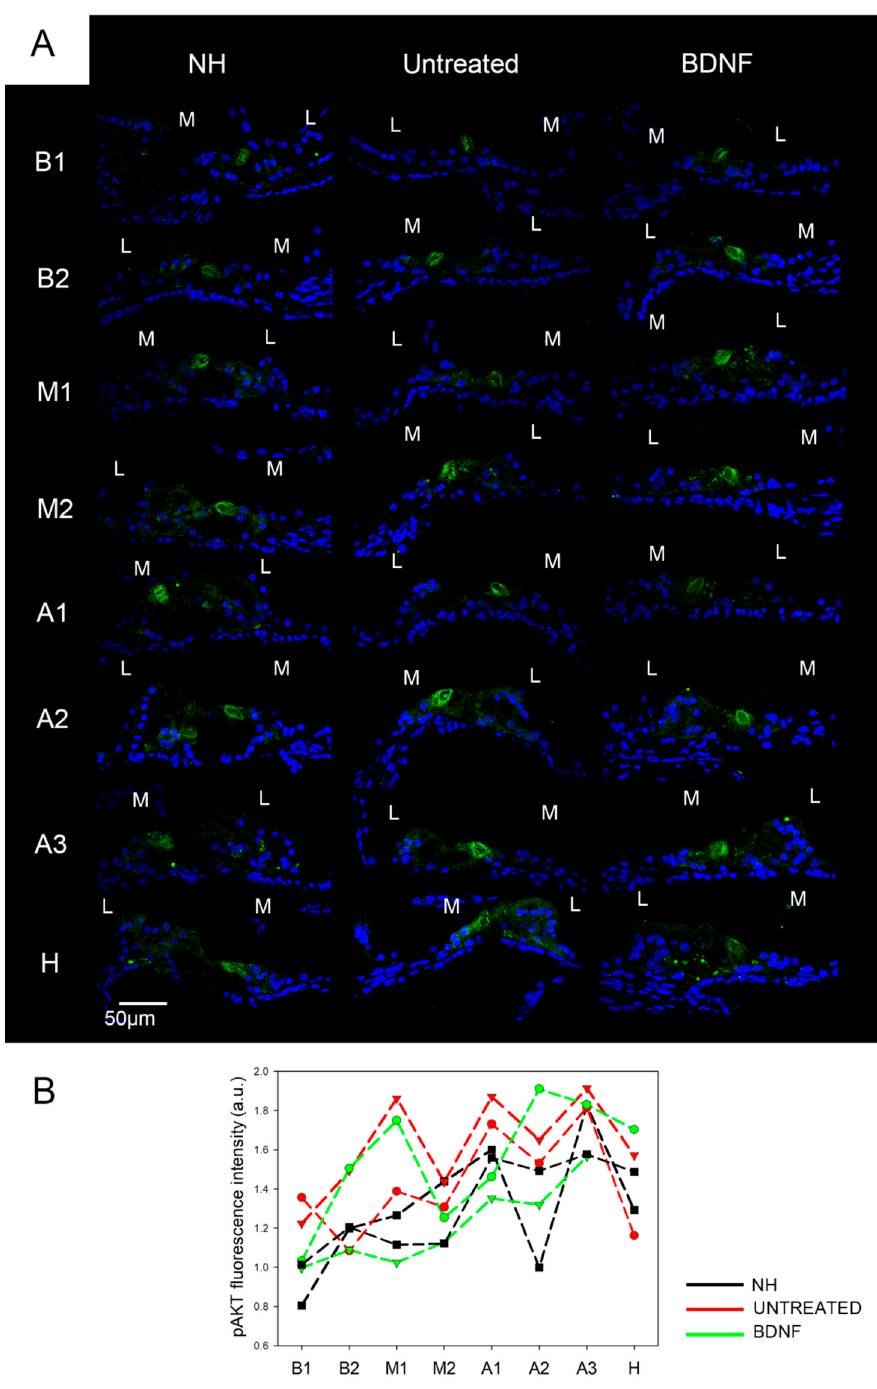
Figure 6. Immunostaining and fluorescence intensity of pAKT. ( A ) Representative confocal images showing the organ of Corti, immunolabeled with anti-pAKT (green) and counterstained with bisbenzimide nuclear dye (blue), of all experimental groups and for each cochlear location (from B1 to H). Scale bar: 50 µm. L: lateral, M: medial. ( B ) Fluorescence intensity analysis of pAKT immunostaining. The graph shows the signal intensity of each sample for all cochlear locations (black: NH, red: untreated, green: BDNF-treated). The same symbol was used to identify the BDNF-treated and untreated ears of individual animals.